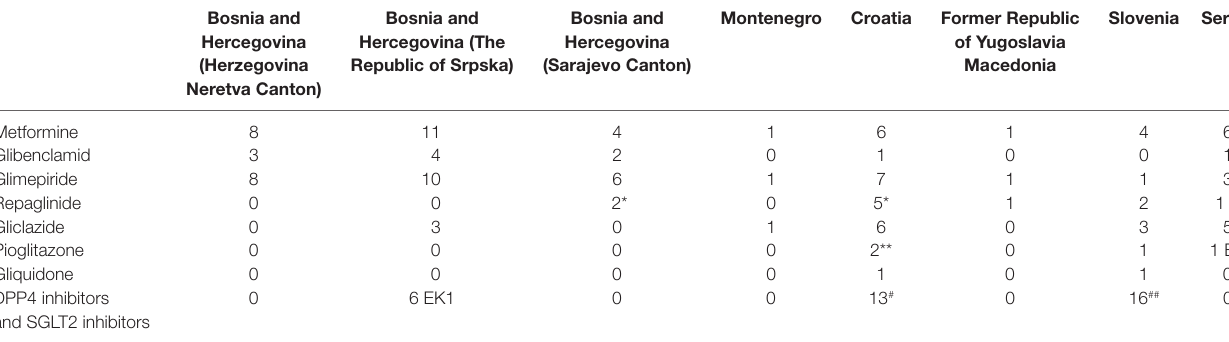
TaBle 7 | Number of parallels of oral antidiabetic agents in countries and cantons.